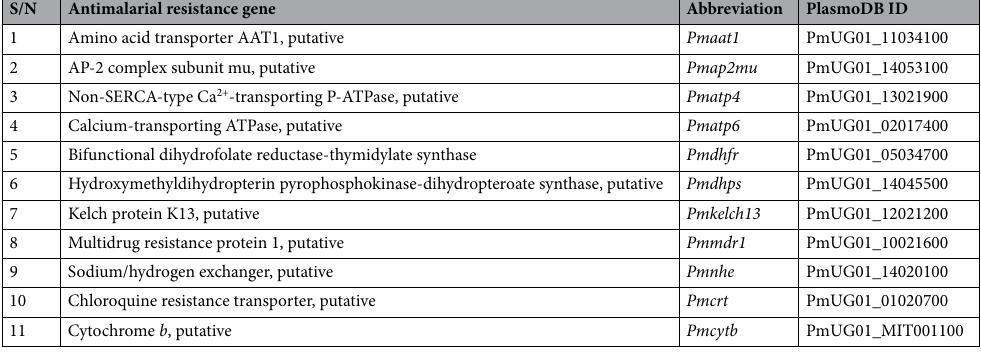
Table 2. List of orthologous P. malariae antimalarial resistance genes